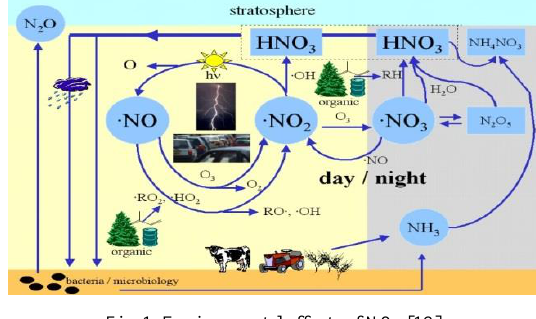
Fig. 1. Environmental effects of NO x [12]